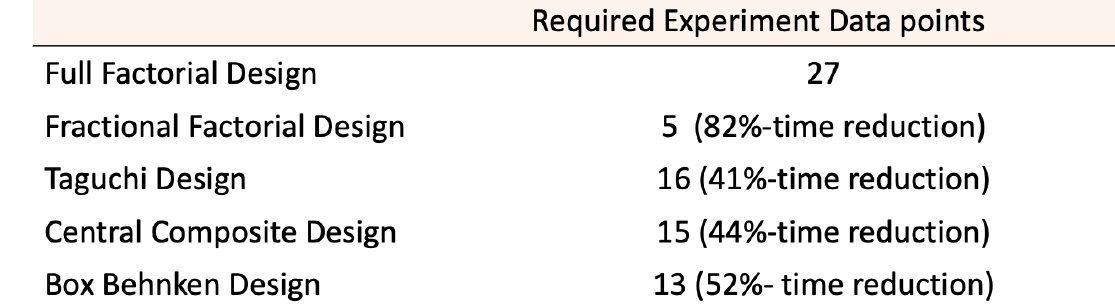
Figure 6. Number of experimental runs required for each design for 3 factors investigated at 3 levels.